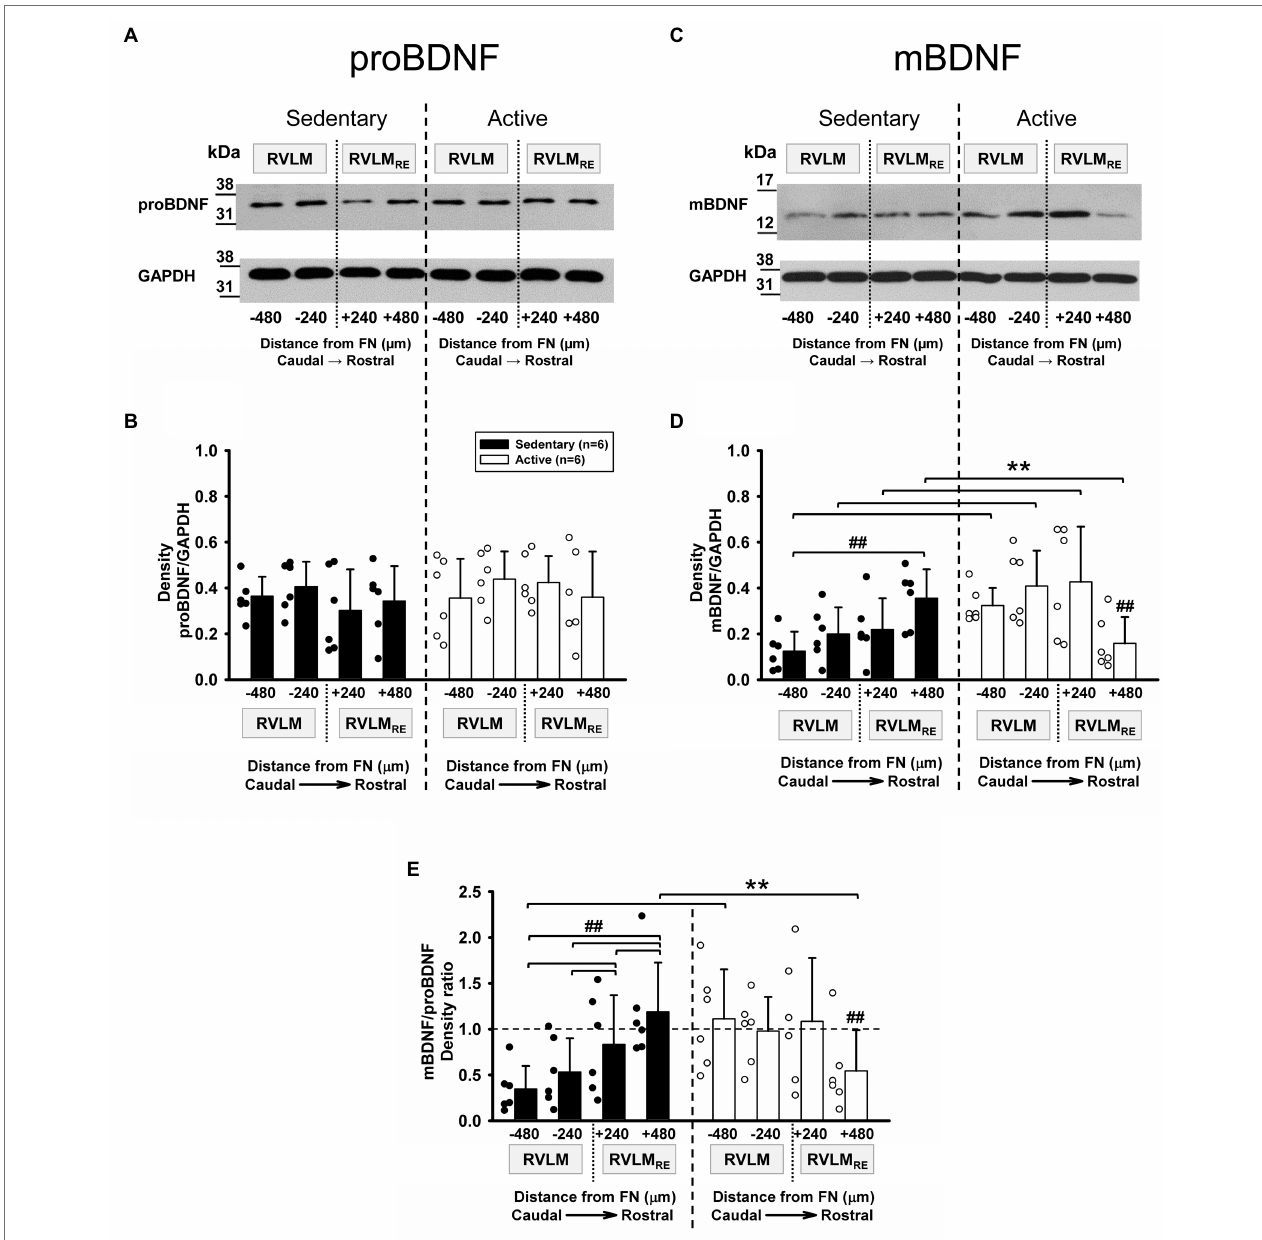
FIGURE 3 | Pro-form (proBDNF) and mature form of BDNF (mBDNF) expression in the RVLM/RVLM RE following 10–12 weeks of sedentary vs. physically active conditions. (A) Representative Western blot of proBDNF and GAPDH expression at different rostrocaudal levels of the RVLM and the RVLM RE . (B) Group data from sedentary (black bars) vs. physically active (white bars) conditions ( n = 6 ea) demonstrate no significant difference in the expression of proBDNF in sedentary rats when compared to physically active animals in the RVLM/RVLM RE [ F (1,30) = 0.31, p = 0.59, main effect of group]. There was also no main effect of rostrocaudal distribution [ F (3,30) = 1.809, p = 0.167] and the lack of significant interaction between experimental groups and rostrocaudal levels [ F (3,30) = 1.388, p = 0.266] precluded further post hoc testing. (C) Representative Western blot of mBDNF and GAPDH expression at different rostrocaudal levels of the RVLM and the RVLM RE . (D) Group data from sedentary (black bars) vs. physically active (white bars) conditions ( n = 6 ea) show a significant interaction term between experimental groups and rostrocaudal levels [ F (3,30) = 11.182, p < 0.001], and the further post hoc test for multiple factor comparisons (Holm–Sidak method), revealed that sedentary rats had significantly lower expression of mBDNF in both subregions of the RVLM (** p = 0.021 for FN-480 and p = 0.015 for FN-240) and in the FN + 240 subregion of the RVLM RE (** p = 0.016). In contrast, the expression of mBDNF was significantly higher in sedentary animals in the most rostral FN + 480 subregion of the RVLM RE (** p = 0.022). ##, significance for rostrocaudal comparisons within sedentary and active groups (see Supplementary Table S1 for post hoc results within experimental groups). (E) Group data showing significant interaction between main effects [ F (3,30) = 22.985, p < 0.001] allowed for post hoc testing which revealed a significantly lower mBDNF/proBDNF ratio in sedentary rats in the most caudal FN-480 subregion of the RVLM (** p = 0.005). In contrast, sedentary rats had